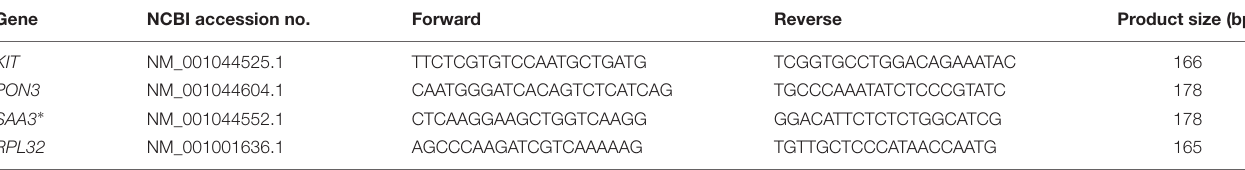
TABLE 1 | Forward and reverse primers and amplicon length used for qPCR